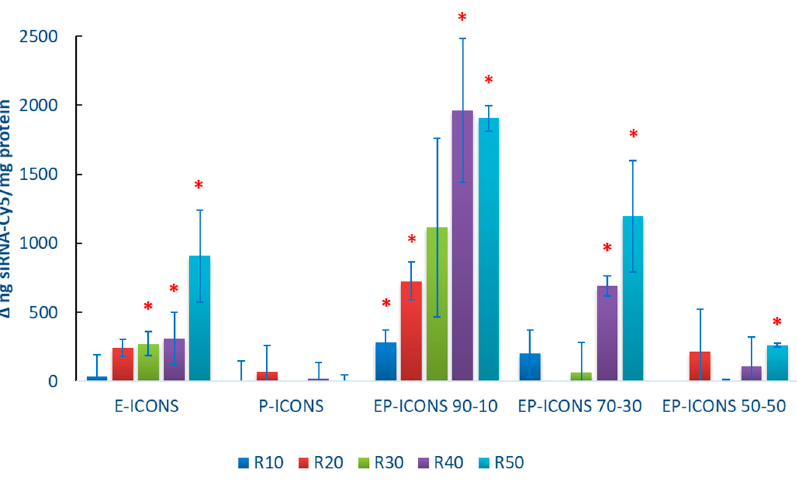
Figure 6. EGF competitive cellular uptake studies. Data are expressed as the differences between uptake without EGF pre-incubation and EGF competitive uptake. Statistically significant values are indicated with asterisks (* p < 0.05).